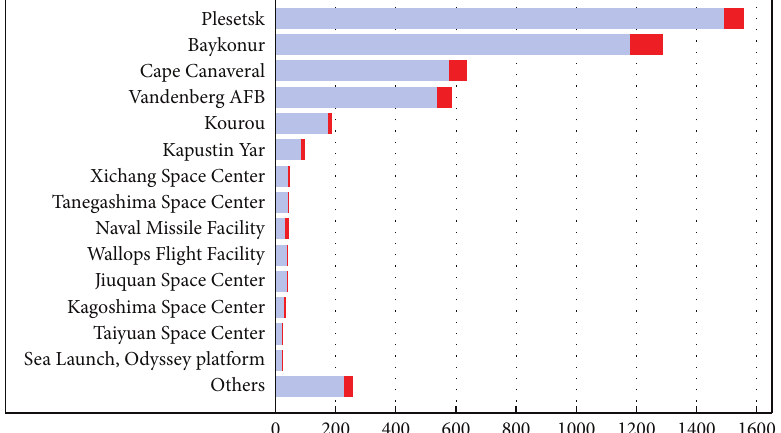
Figure 2: Number of launches from the most-used space ports in the world from 1957 till 2008. Red mark denotes